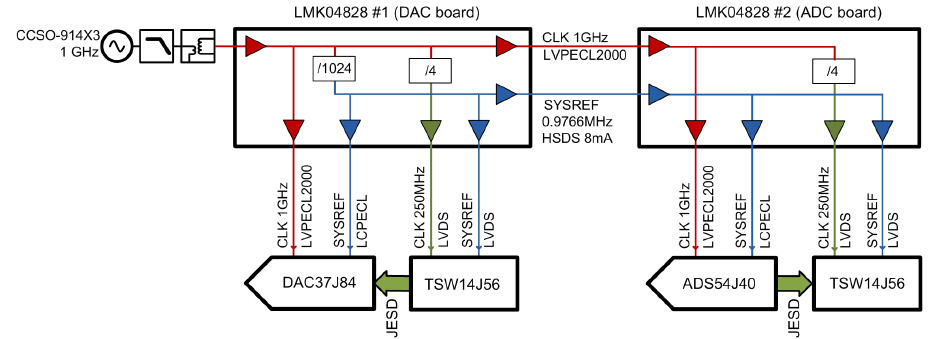
Figure 3. Clock tree.